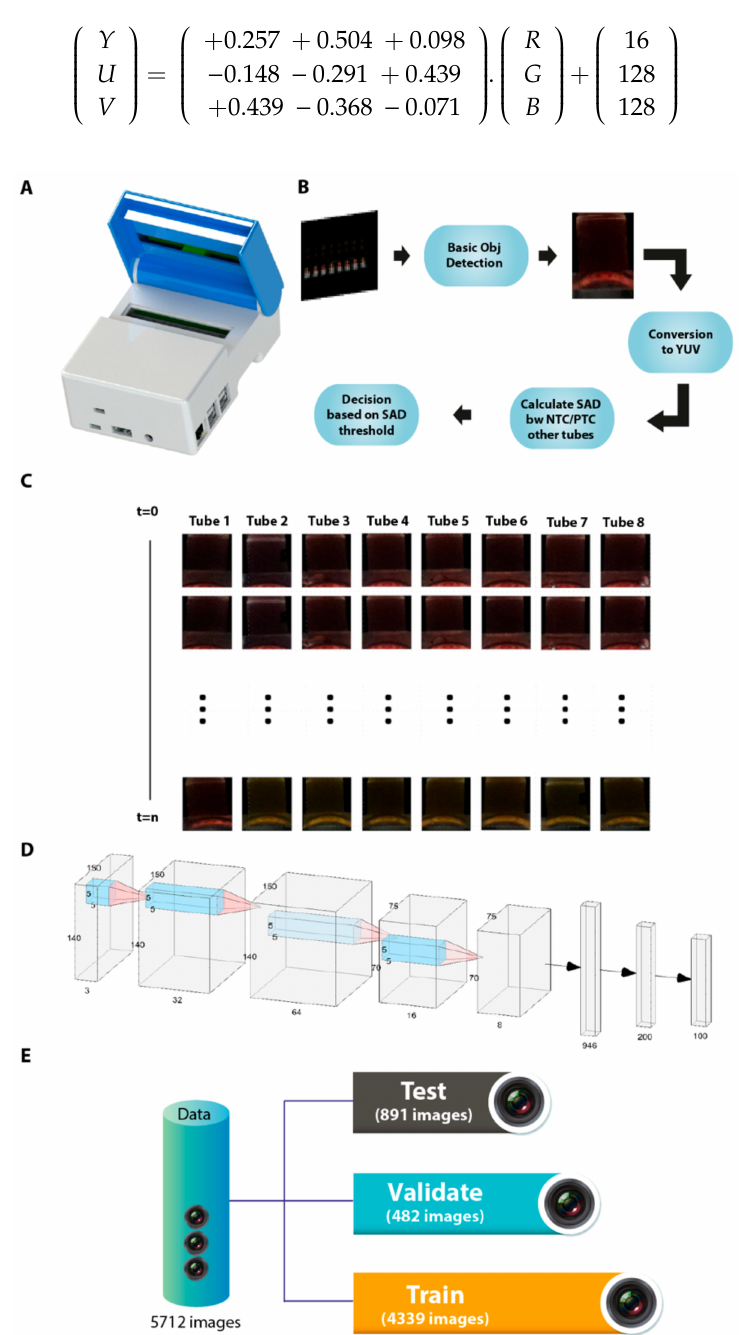
Figure 4. Fabrication and processing of LAMP data for enhanced detection of SARS-CoV-2. ( A ) Exterior of a smart diagnostic device ( B ) Description of the artificial intelligence (AI)-assisted algorithm and image processing. ( C ) Pipeline to process images and extraction of colorimetric information. ( D ) Schematic outlining the training of the network for image processing. ( E ) Data division for training, validation and testing of the AI